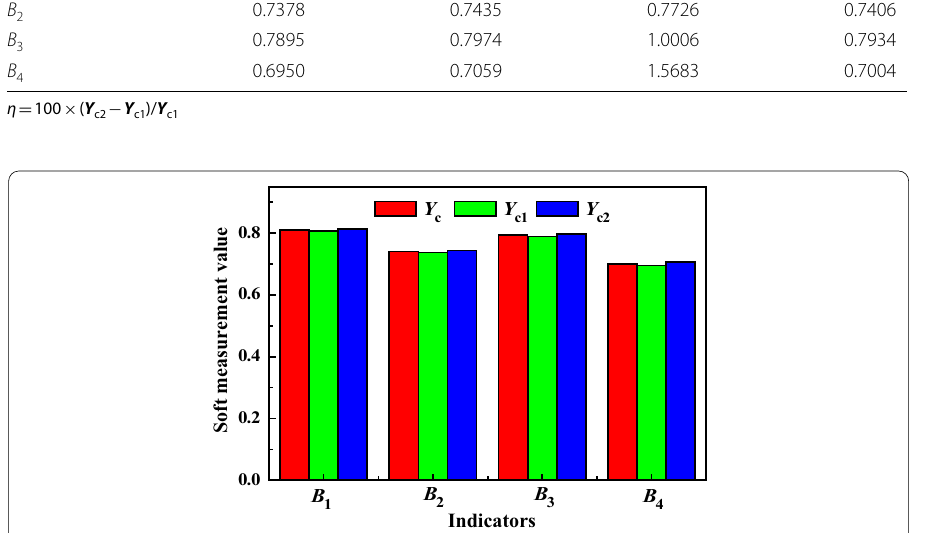
Fig. 6 Soft measurement values of key index parameters of new competitive advantages of China’s